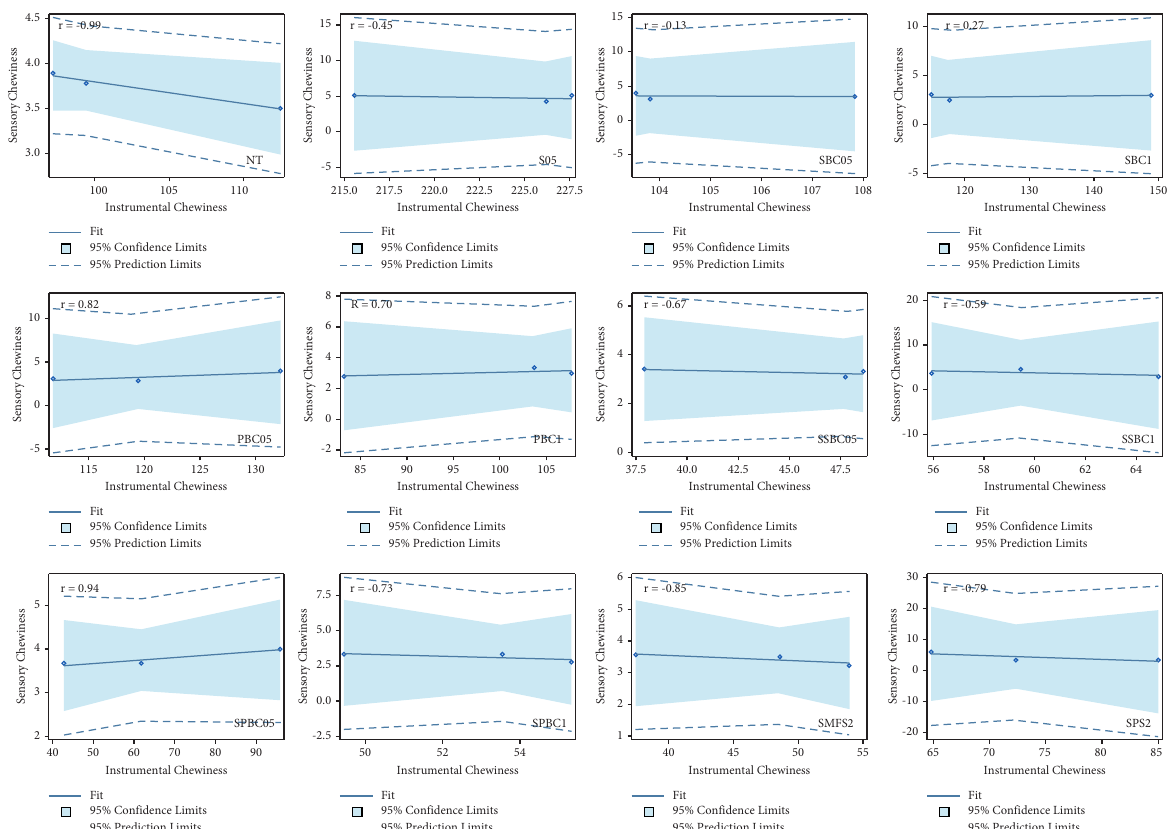
Figure 2: Scatter plot correlation matrix comparing the chewiness sensory descriptive analysis and instrumental texture profile analysis of ground beef treated with different levels of sodium bicarbonate, potassium bicarbonate, salt, modified food starch, and potato starch. Control: NT; salt (0.5%): S05; sodium bicarbonate (0.5%): SBC05; sodium bicarbonate (1.0%): SBC1; potassium bicarbonate (0.5%): PBS05; potassium bicarbonate (1.0%): PBC1; sodium bicarbonate+salt (0.5%+ 0.5%): SSBC05; sodium bicarbonate+salt (1.0% +0.5%): SSBC1; +salt (0.5%+0.5%): SPBC05; potassium bicarbonate +salt (1.0% +0.5%): SPBC1; modified food starch+salt (2.0% +0.5%): SMSF2; potato starch+salt (2.0% +0.5%):